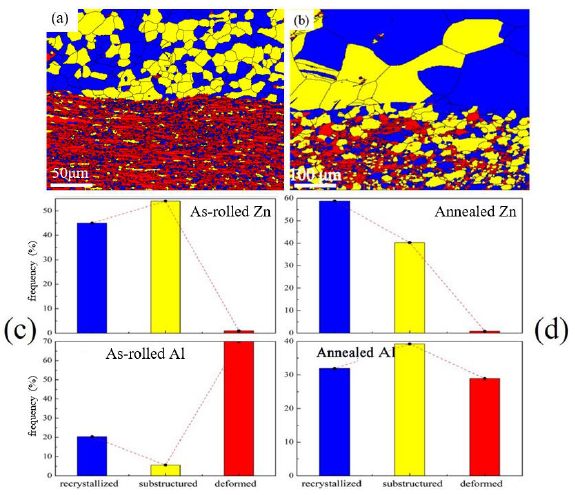
Figure 8. Recrystallization change at the interface of Al/Zn laminated composite plate at 1000 × for rolling state ( a ) and 500 × for 280 ◦ C × 2 h ( b ); Proportion of recrystallization, substructure and deformation texture at the interface of Al/Zn laminated composite plate under 1000 × for rolled condition ( c ) and 500 × for 280 ◦ C × 2 h ( d